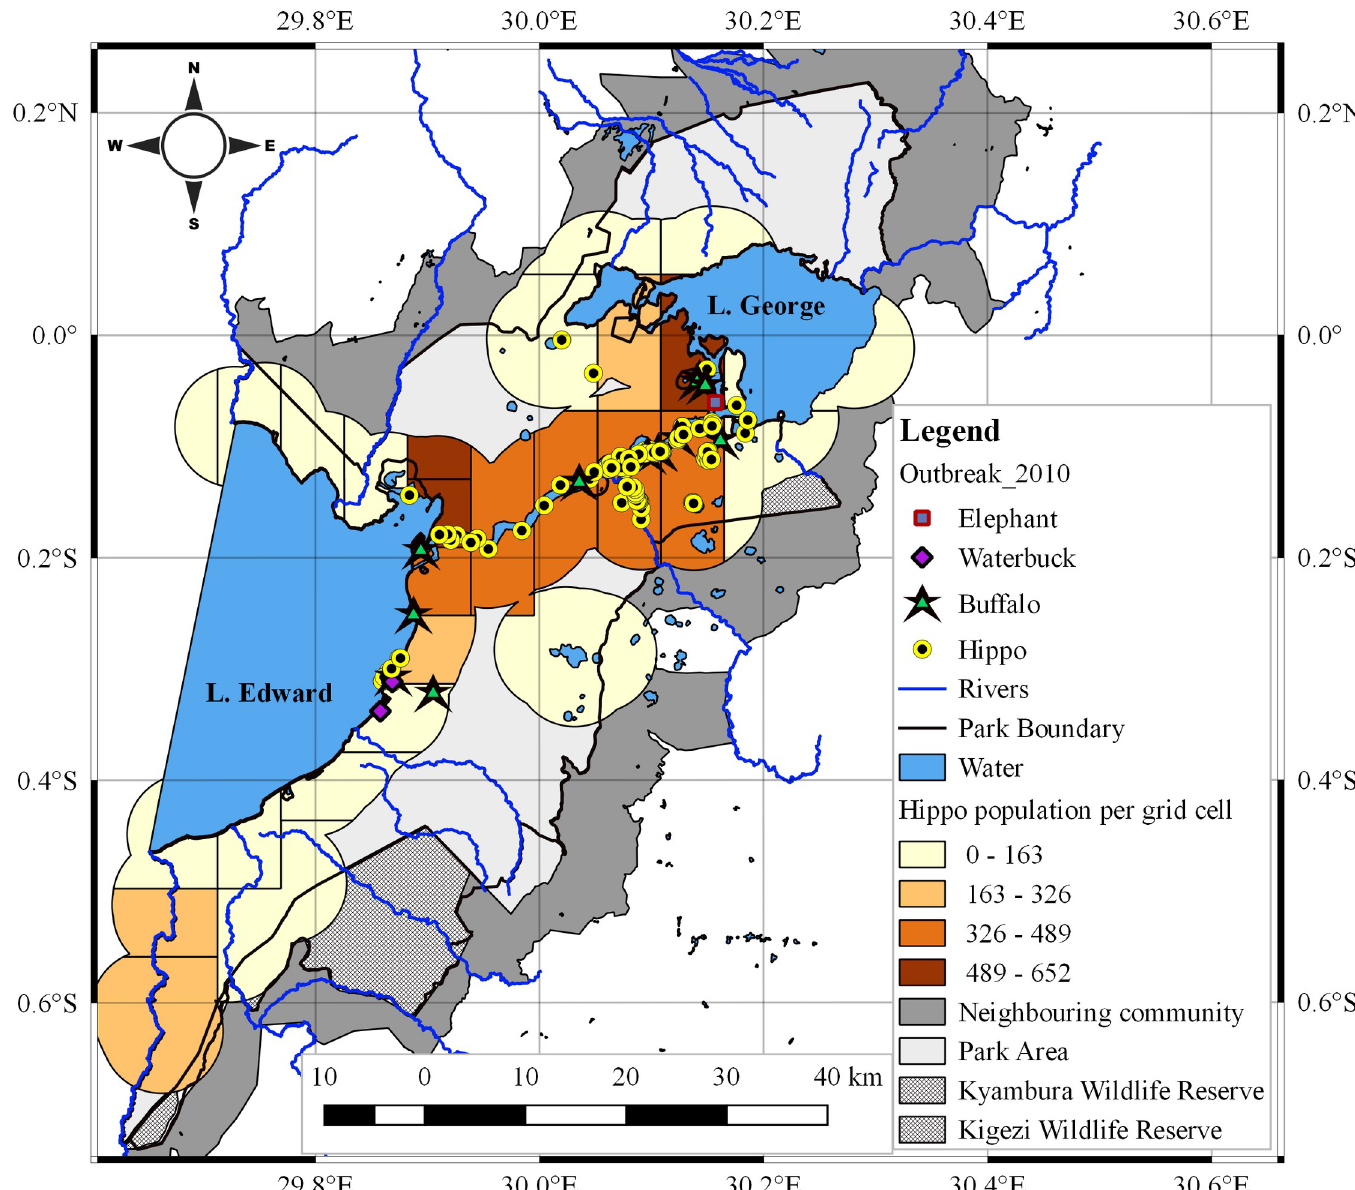
Fig 2. patial distribution of anthrax cases relative to hippo population size in